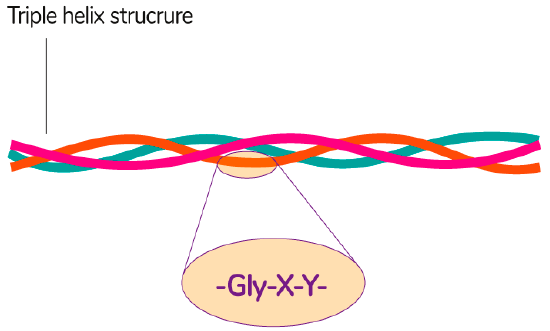
Figure 8. The general structural features of collagen [135]. Reproduced from Sebald, A., proof- read/edited by Mitchell, D.A. Maxfacts; published by University of York, 2019.